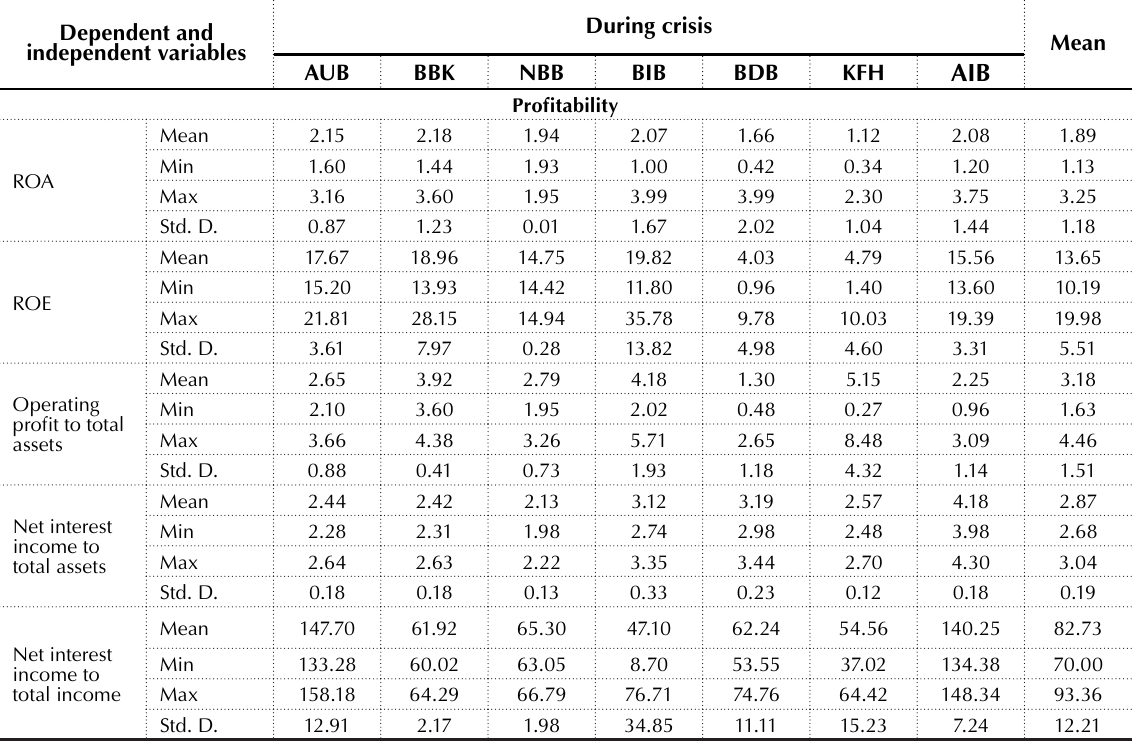
Source: authors’ calculations.